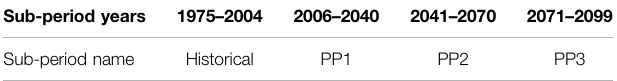
TABLE 3 | Temporal split of the climate